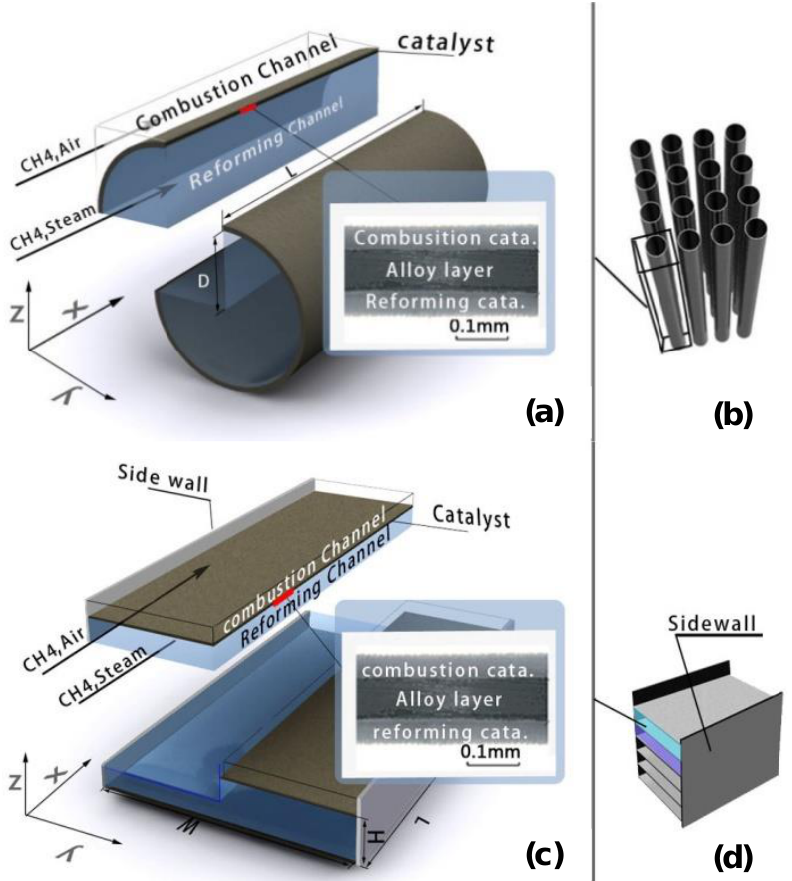
Figure 1. Schemas of box-type ( a ) and tube-type ( c ) reformer cells (the reformer cells can be scaled up as ( b ) and ( d )), (Symbols description: D = diameter, H = height, W = width, L = length, X = X-axis, Y = X-axis, Z = Z-axis . Table 1. Reaction conditions and catalyst parameters.